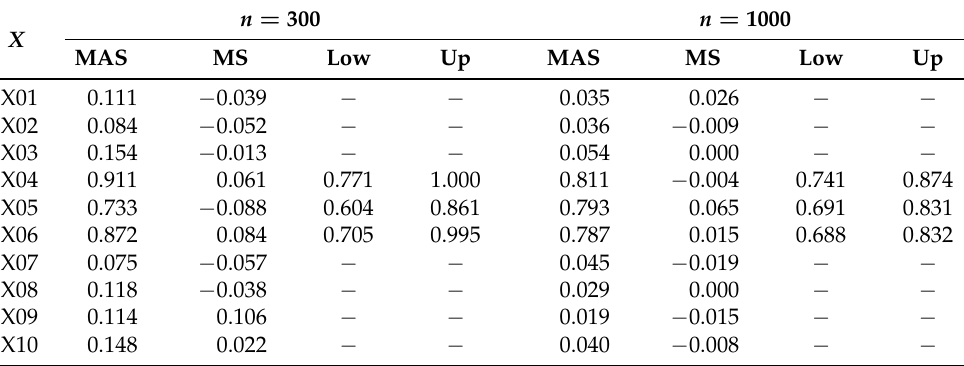
Table 4. Model M2 (De Vleaux), mean absolute sensitivity (MAS), mean sensitivity (MS), lower (Low) and upper (Up) bootstrap confidence interval limits with B = 1999 replicates and nominal level 1 − α = 0.90, for n = 300, and n = 1000 observations. For those variables that were not relevant, no confidence limits are